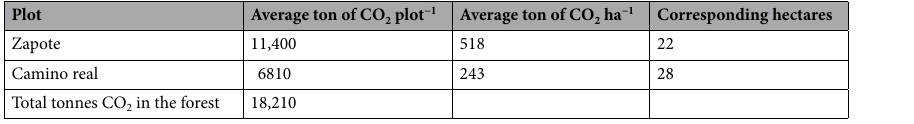
Table 2. Estimation of the carbon storage in the CIEE forest, Monteverde, Costa Rica.